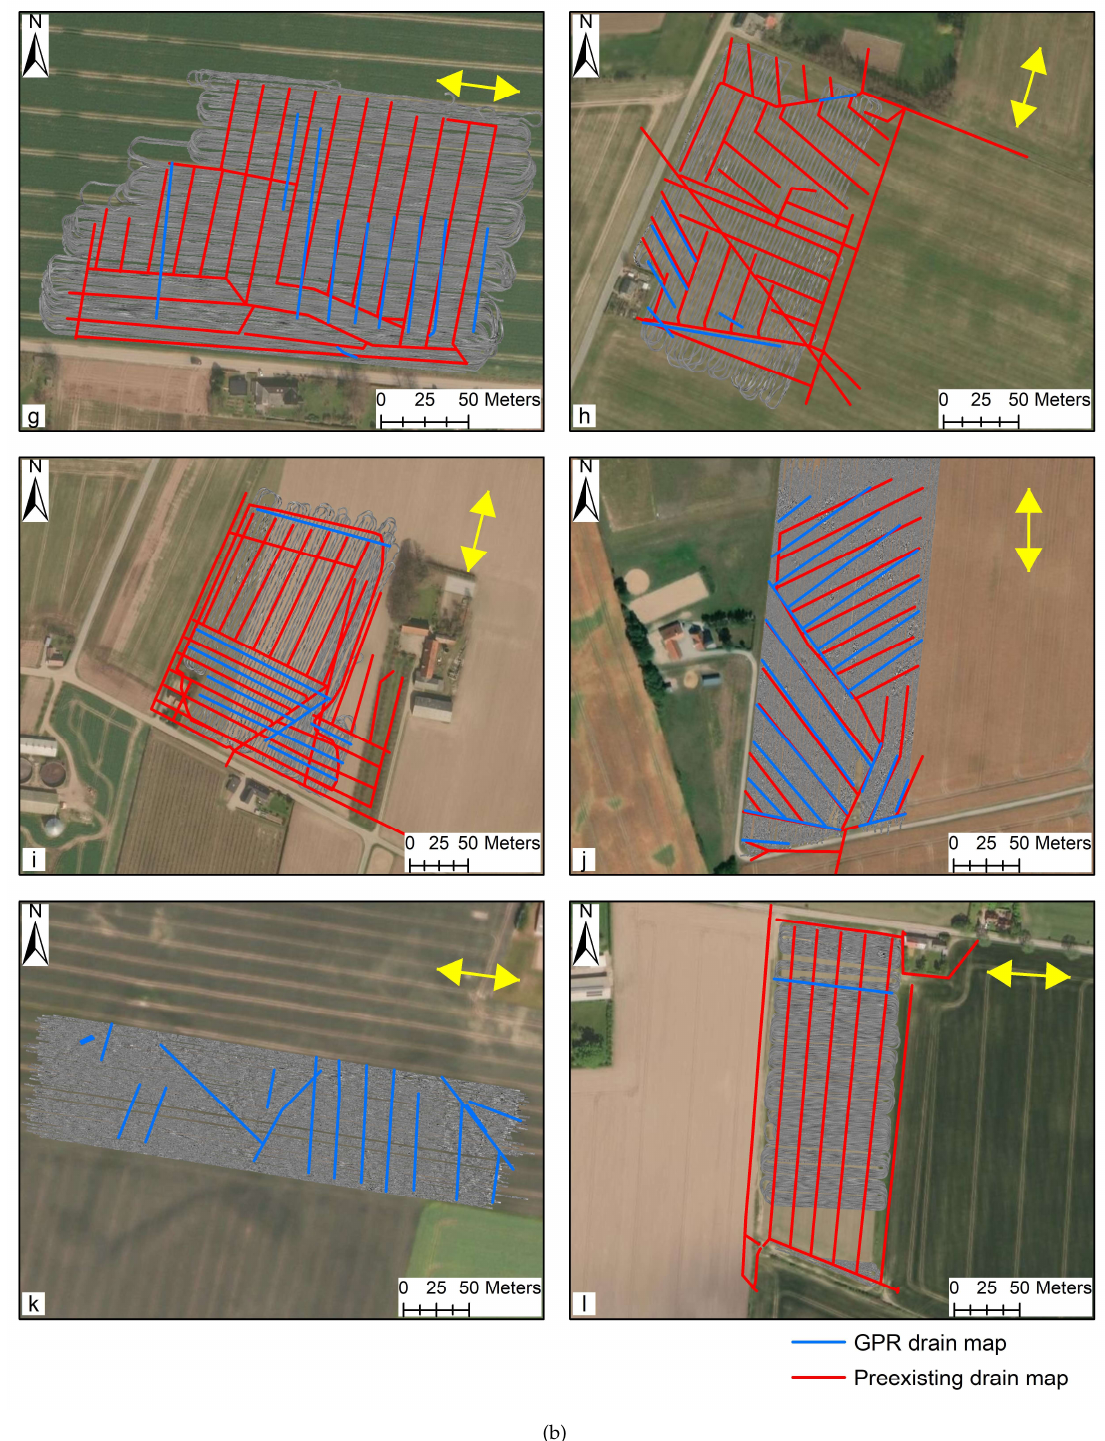
Figure 7. The drains mapped using the 3D-GPR instrument (blue) overlain on pre-existing drain maps (red) and the 3D-GPR survey transects at the di ff erent sites: ( a ) Fensholt upland, ( b ) Fensholt lowland, ( c ) Silstrup, ( d ) Estrup, ( e ) Faardrup, ( f ) Holtum, ( g ) Lillebæk-1, ( h ) Lillebæk-2, ( i ) Lillebæk-3, ( j ) Juelsgaard, ( k ) Kalundborg, and ( l ) Lund. The pre-existing drain map at the Holtum and Kalundborg sites were missing. Yellow arrows indicate the 3D-GPR survey directional trend and a base map provided by ArcMap 10.6 ([88]) was used as the background at all the